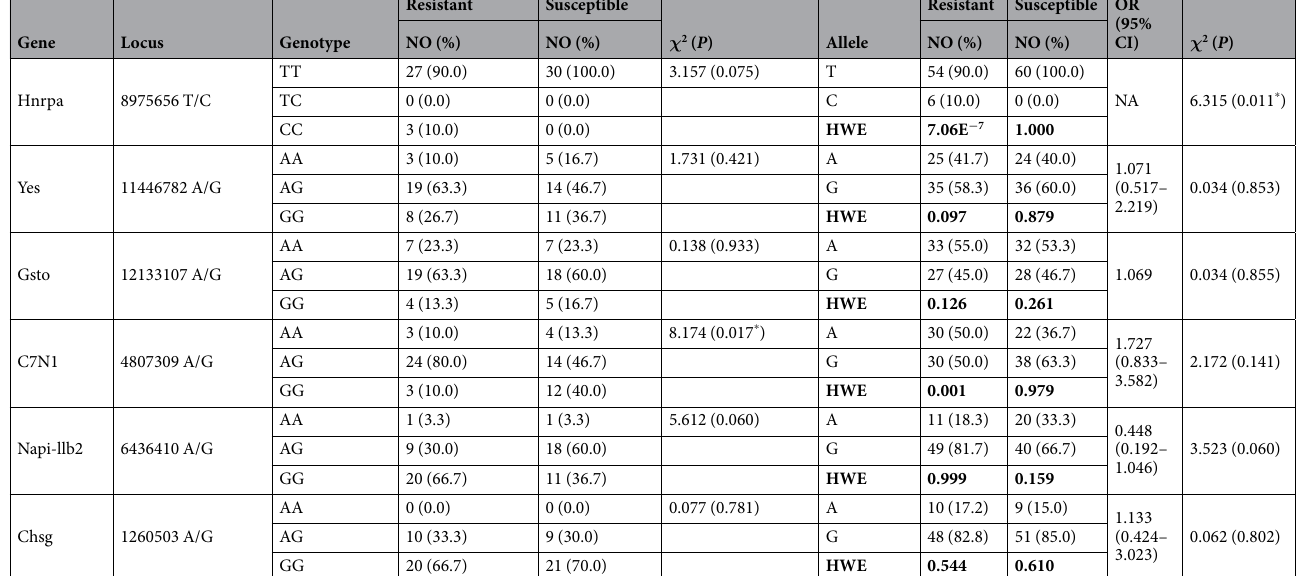
Table 3. Distribution of the SNPs in resistant and susceptible groups. Note: * The distributions of corresponding SNPs between resistant and susceptible groups are significantly different ( P < 0.05). ‘NA’ indicates not available. P values for HWE test are shown with boldface.